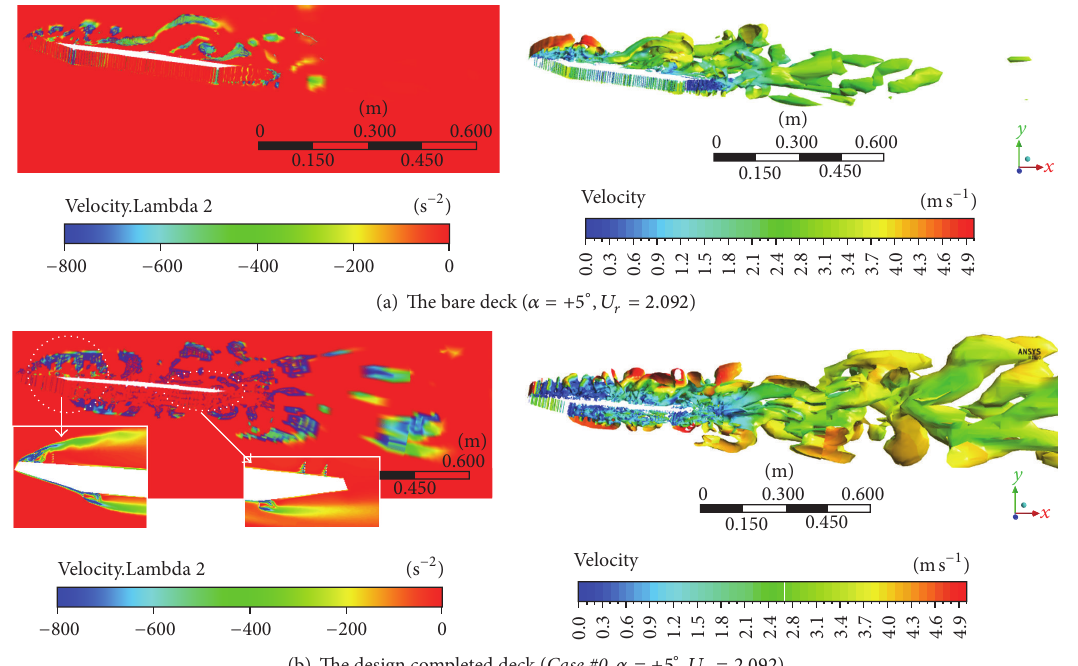
Figure 10: Vortex core structures under stationary conditions. Left: contour map of 𝜆 2 ; right: ISO surface of 𝜆 2 = −10 s −2 .